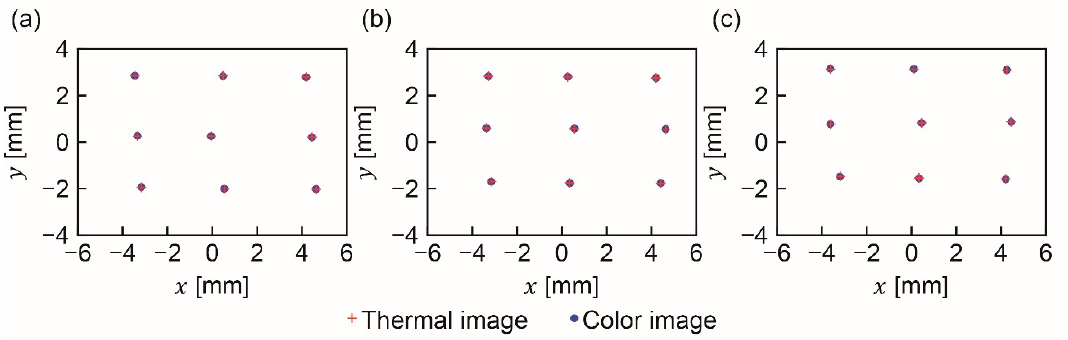
Figure 9. Positions of the light source at distances of ( a ) 0.5, ( b ) 1, and ( c ) 2 m in captured color images and mapped thermal images. The mapping was estimated using pairs of images of the light source at a distance of 1 m.